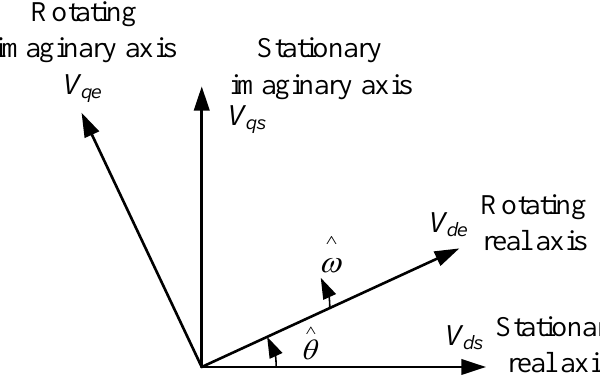
Figure 4. Estimated reference frame for a single-phase system.